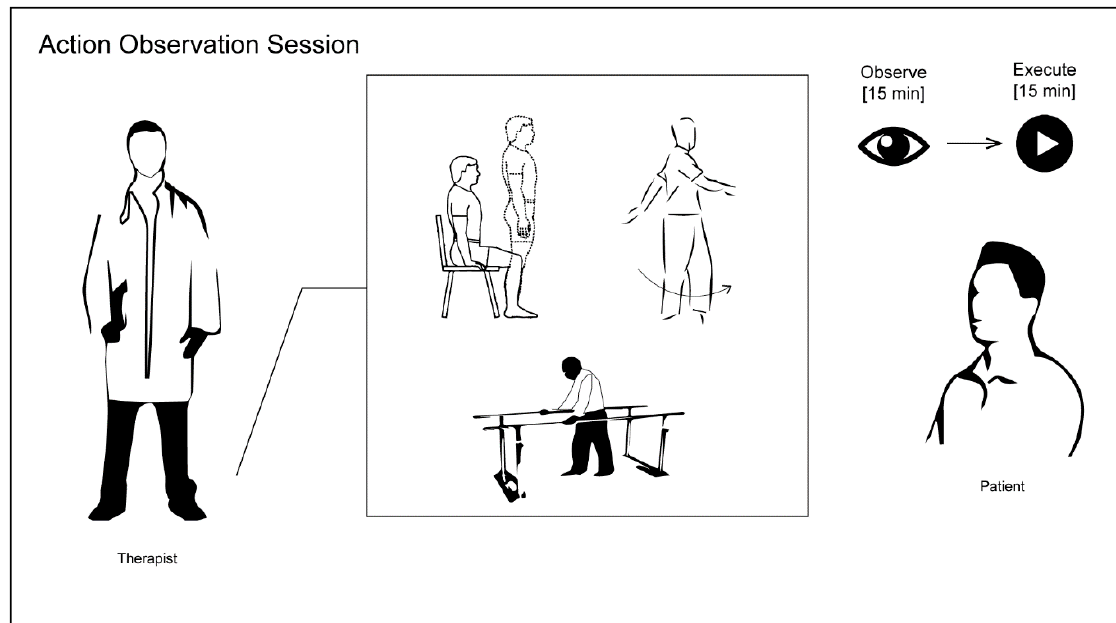
Figure 1. Overview of Action Observation session: The patient first observes the single action (e.g., rising from a chair, 90° walking turn, going through walking parallel bars) performed by the physical therapist, then is asked to execute the action previously observed.